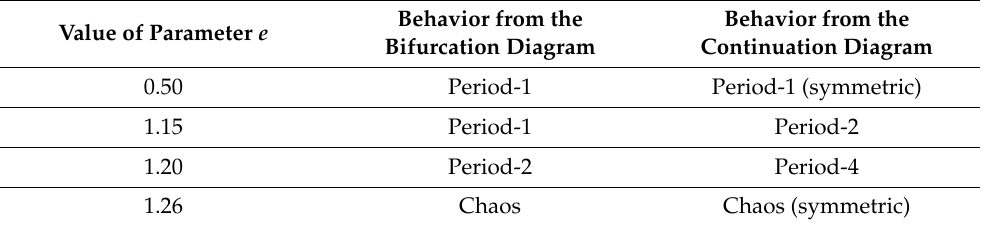
Table 2. Coexisting attractors as they are observed from the comparison of the bifurcation diagram with the respective continuation diagram of variable x versus the parameter e , for a = 4 × 10 − 4 , b = 1, c = 3.846 × 10 − 4 , d =